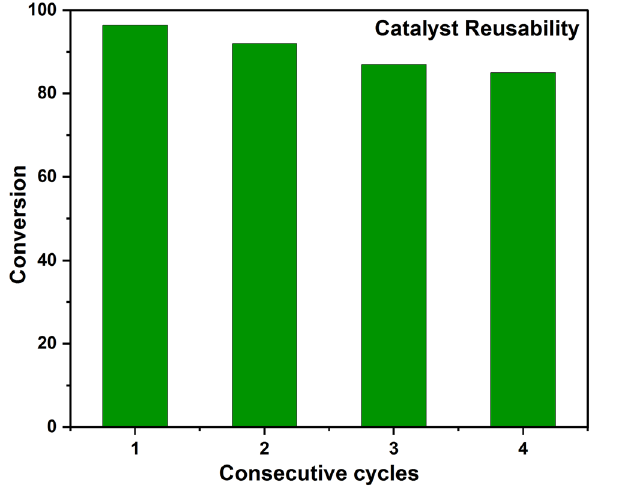
Figure 11. Reusability of SANH18